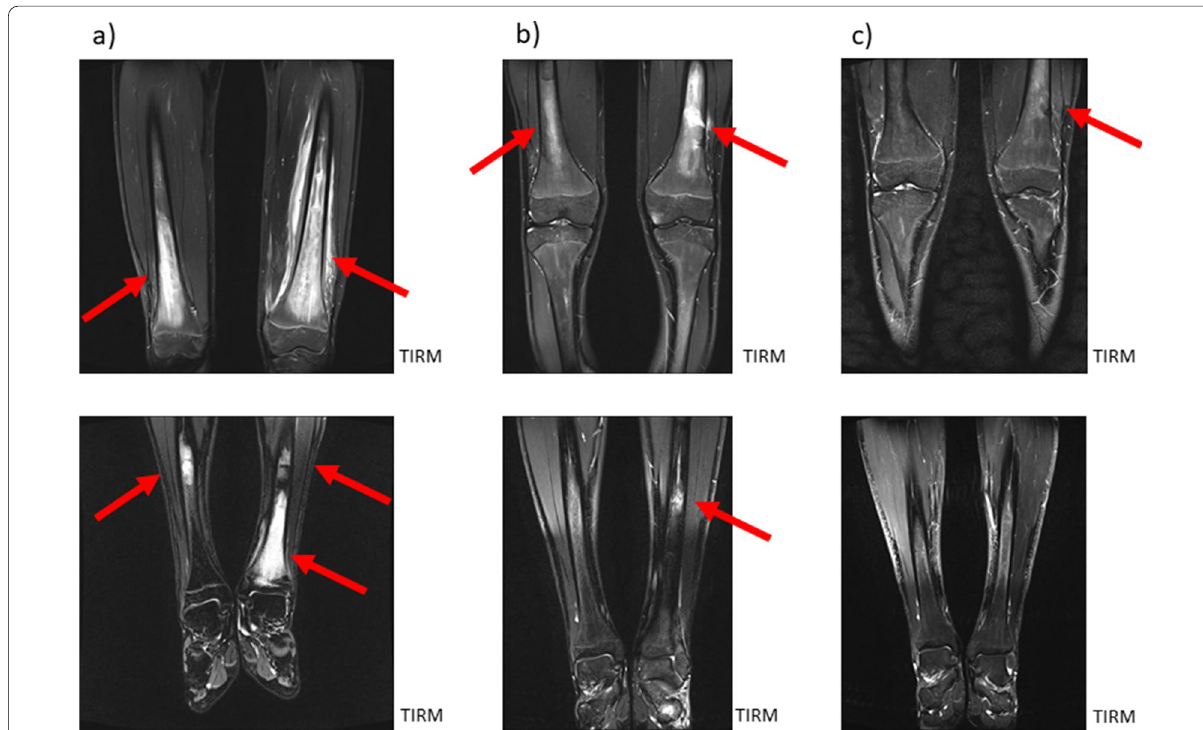
Fig. 5 A 16-year-old adolescent with exhaustion for 2 months, bone and muscle pain. MRI showed extensive bone marrow edema in the distal femora and tibiae, marked concomitant soft tissue reaction within the left femur and less marked in the left tibia. After bone biopsy (femur) and diagnosis of CNO, initial therapy with naproxen yields clinical regression. MRI demonstrated regression. Under naproxen therapy asymptomatic patient with still visible